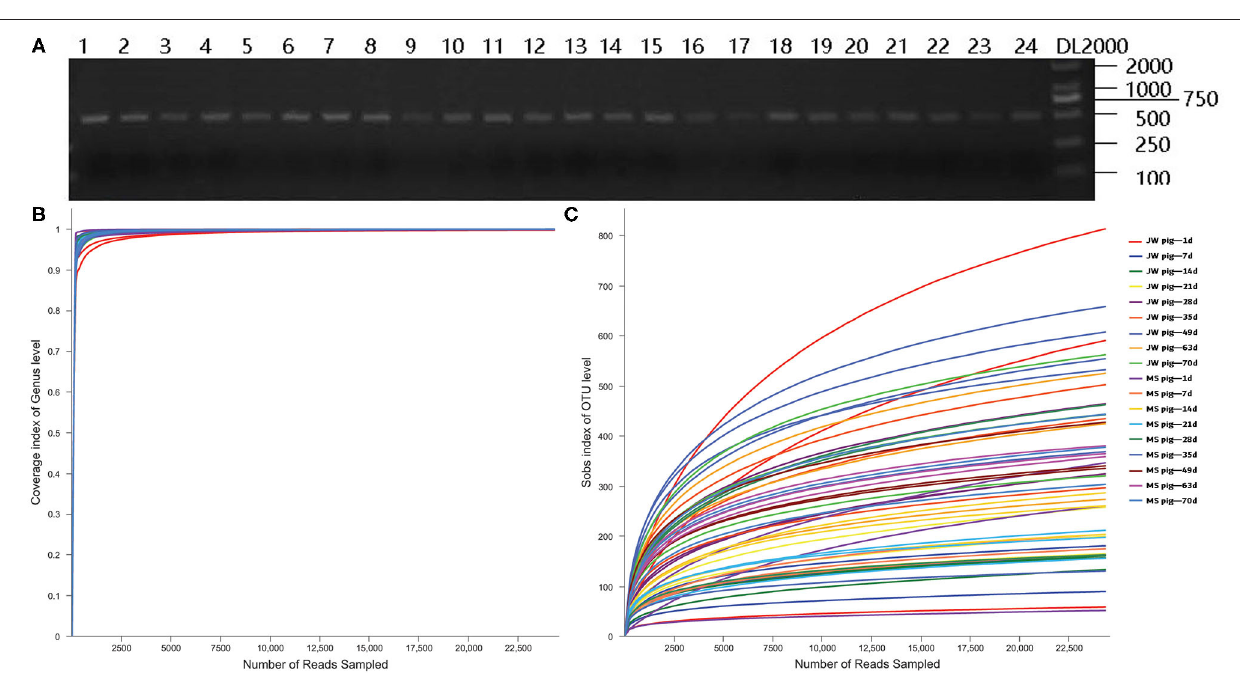
FIGURE 2 | PCR assay with primers targeting 16S rRNA and quality control of the sequencing data. (A) Electrophoresis gel image of PCR products amplified using 16S rRNA primers, (B) Coverage plots, and (C) Sobs rarefaction curves. JB, Jinfen White pigs; MS, Mashen pigs; and F,